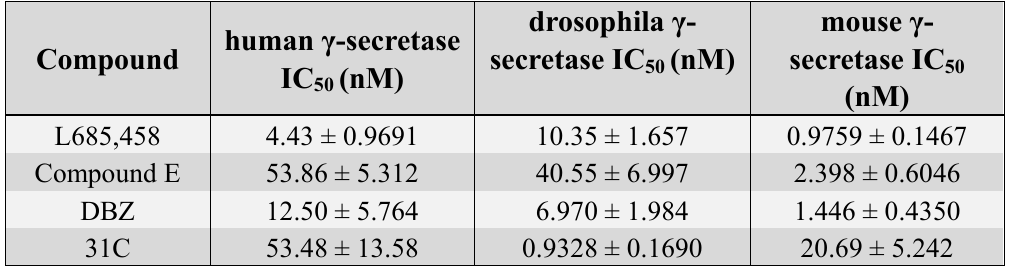
values of various compounds obtained with human, 50